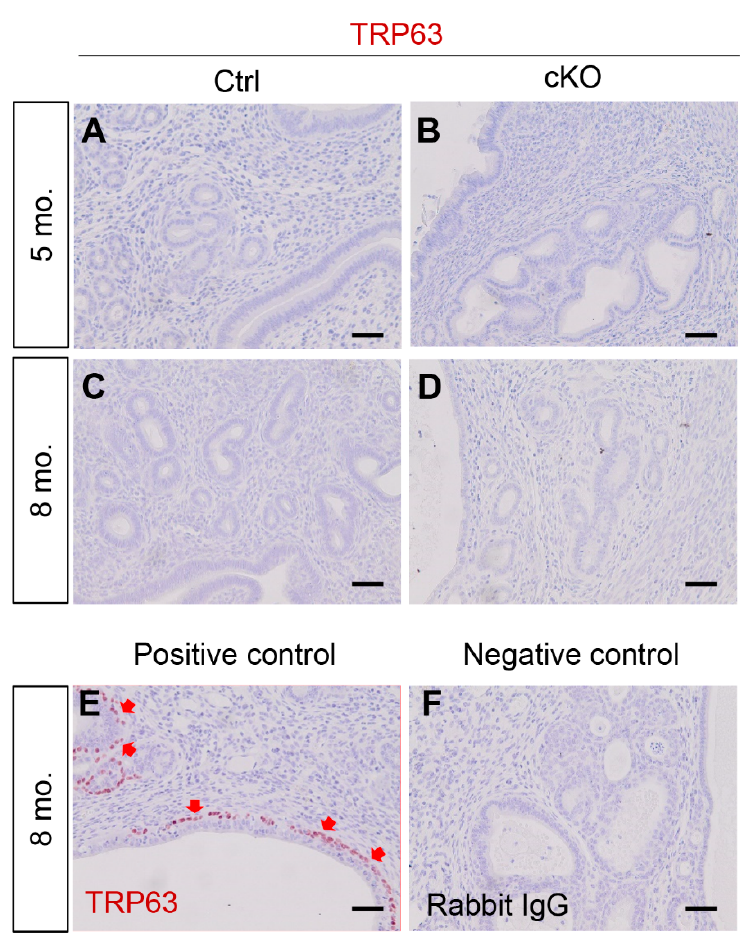
Figure 3. Basal-like cells do not develop in Ezh2 Amhr2 -Cre cKO mice. ( A – D ) Immunostaining of TRP63 using uteri from control and Ezh2 Amhr2 -Cre cKO mice at 5 and 8 months of age. At least three animals for each genotype were examined. ( E , F ) The respective positive and negative control using uterine sections from an 8-month-old Ezh2 Pgr -Cre cKO mouse. Red arrows indicate some TRP63 ‐ positive cells surrounding the epithelial compartment. Scale bar = 50 μ m ( A – F ).